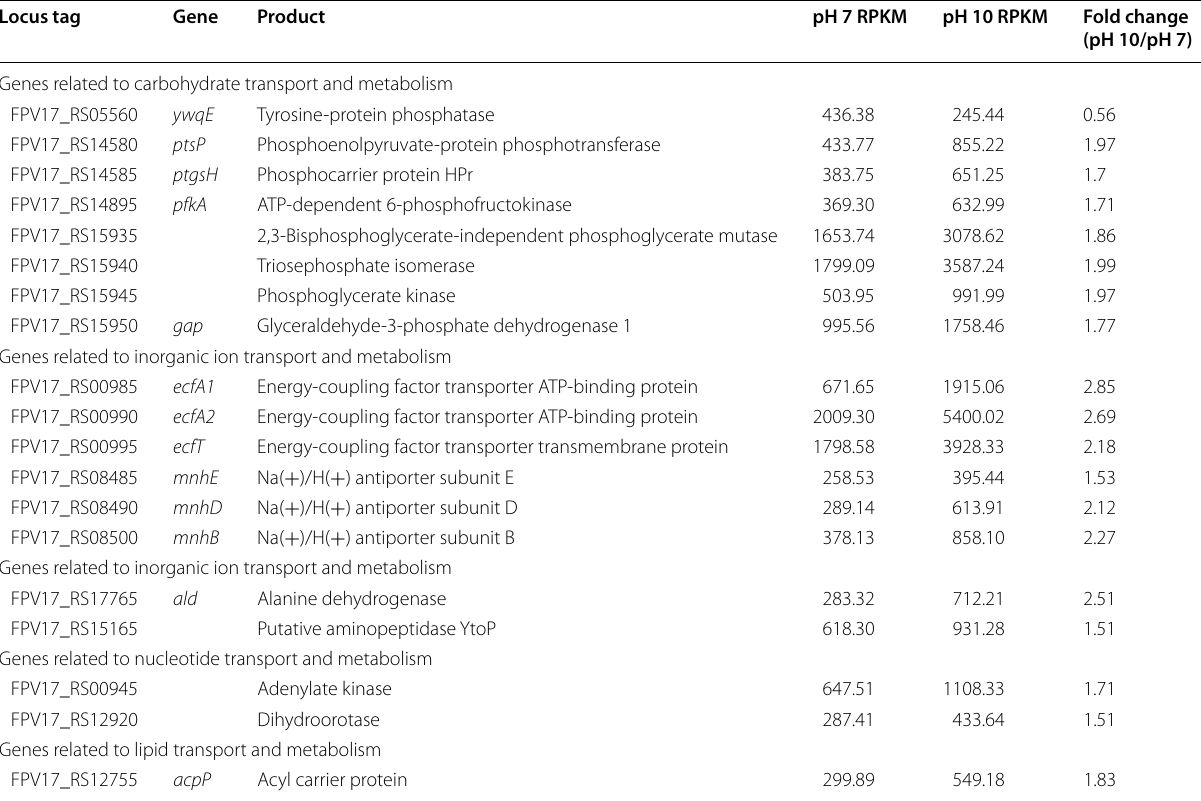
Table 2 Genes belonging to the transport and metabolism COG category whose expression increased by at least 1.5 times in alkaline conditions (RPKM > 100, p <